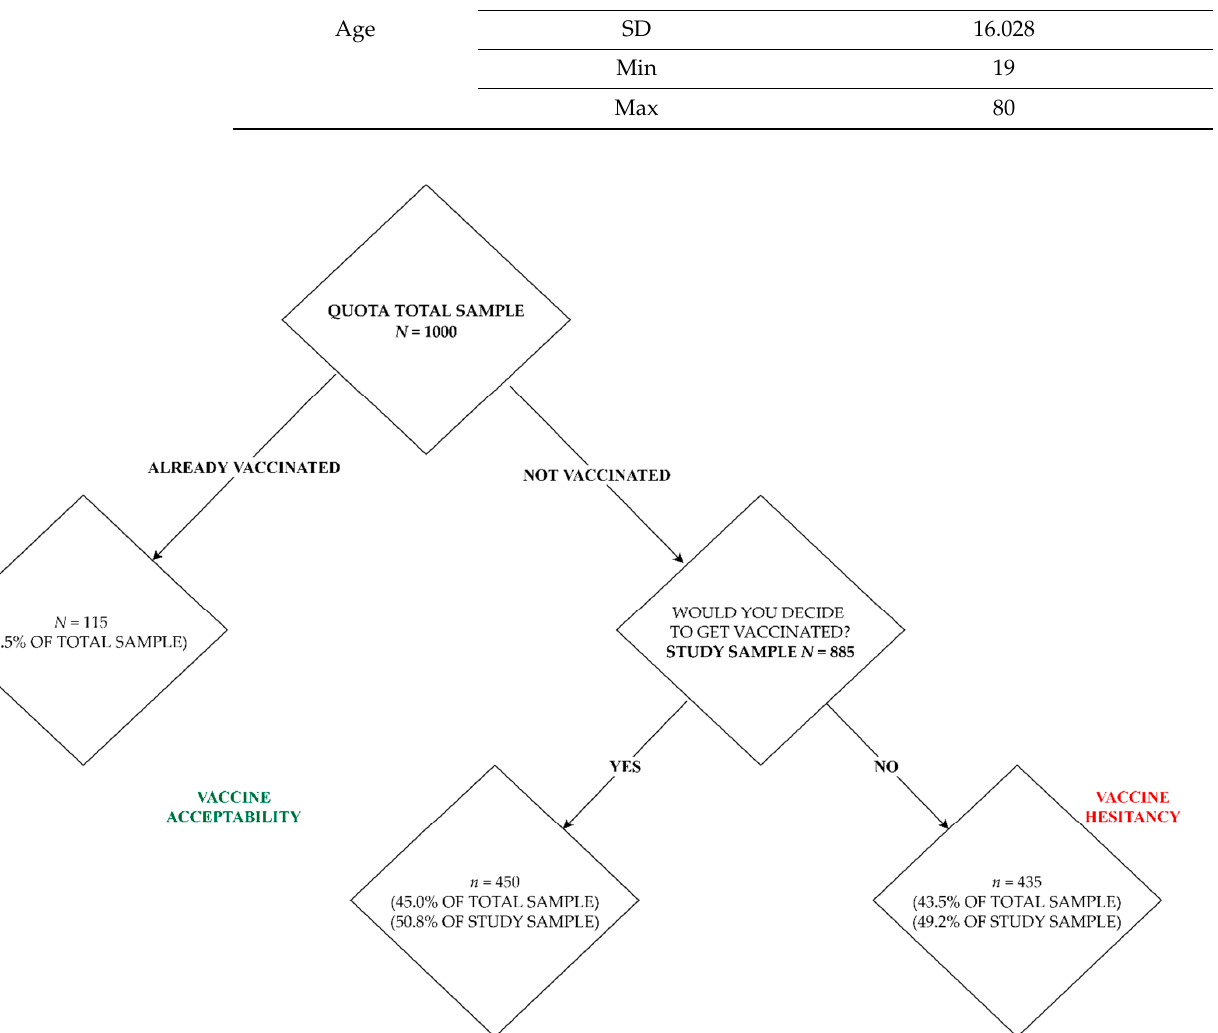
Table 3. Trajectories and variables use for the logistic regression models .